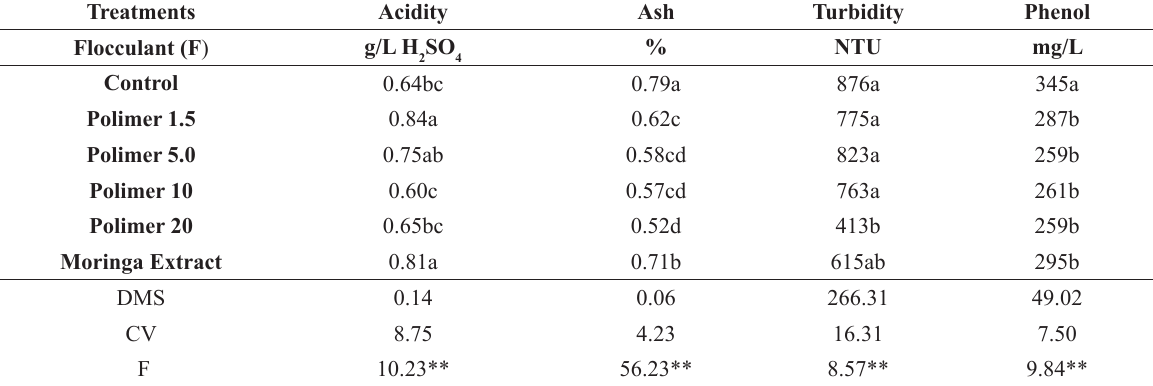
Mean values obtained for Acidity, Ash, Turbidity and Phenol of the juice clarified with 5 sedimentation aids. Jaboticabal- SP. 2015/2016 crop